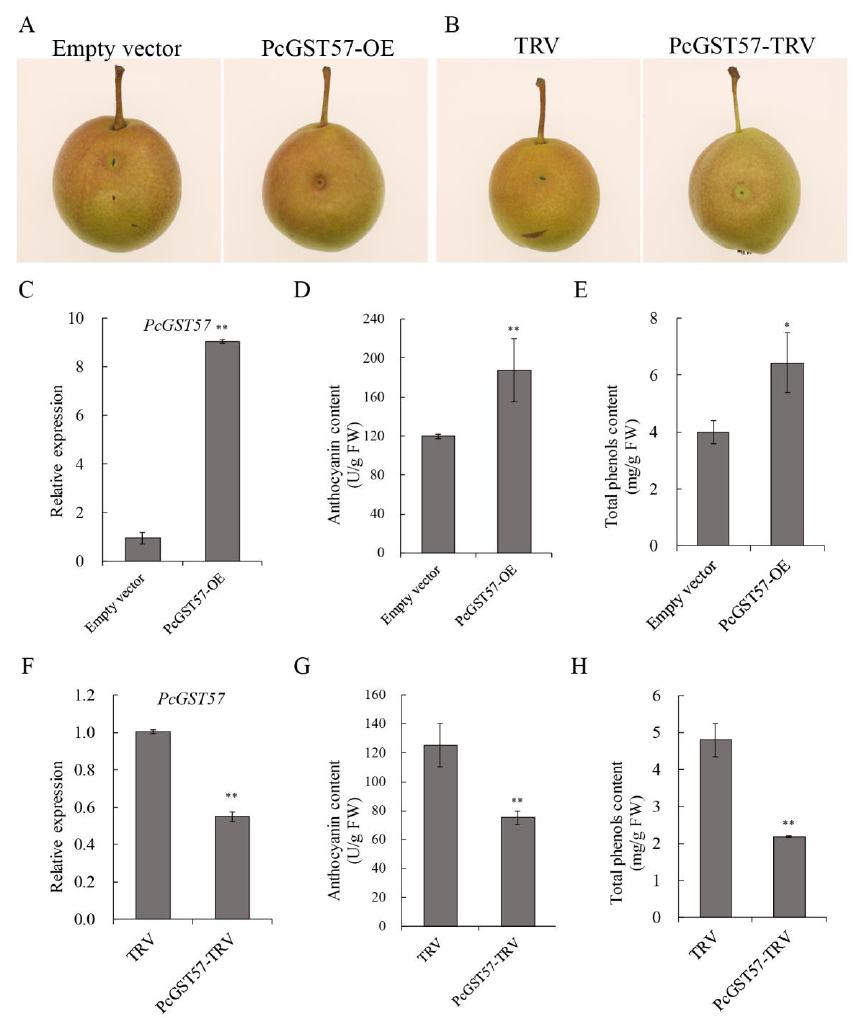
Figure 9. Functional identification of PcGST57 by transient expression in ‘Danxiahong’ pear peels. Transient overexpression ( A ) and TRV-mediated silencing ( B ) assays of PcGST57 in ‘Danxiahong’ pear peels. Transcript analysis of PcGST57 in overexpressing peels ( C ) and silencing peels ( F ). Measurement of anthocyanin content in PcGST57 overexpressing peels ( D ) and silencing peels ( G ). Measurement of total phenol content in PcGST57 overexpressing peels ( E ) and silencing peels ( H ). The photograph were captured 15-day post injection, and the peels around the injection sites were sampled for expression analysis and measurement of anthocyanin content and total phenol content. Pctubulin was used as the internal control for gene expression analysis. All the data indicate means ± SD of three biological replicates. Asterisks indicate statistical significance (*, p < 0.05; and **, p < 0.01) determined by student’s t -test compared with corresponding